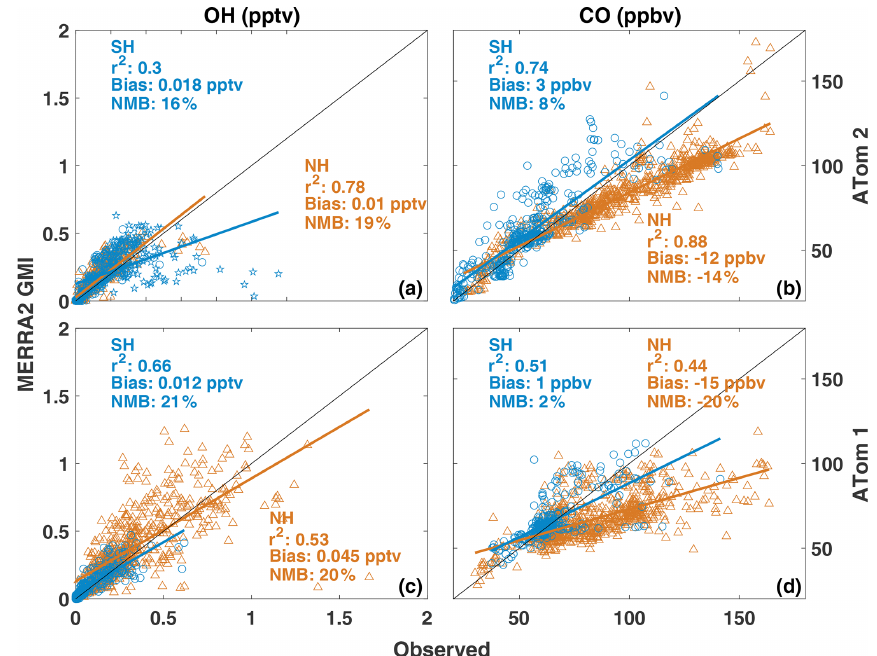
Figure 1. Regression of observed OH (a, c) and CO (b, d) from ATom 2 (boreal winter 2017; a , b ) and ATom 1 (boreal summer 2016; c , d ) against hourly output from MERRA-2 GMI interpolated to the ATom flight track. Data from the Southern (blue circles) and Northern (orange triangles) hemispheres are shown, along with the r 2 , bias, and normalized mean bias (NMB) for each hemisphere. Observations and model output have been filtered for biomass burning influence. Observations of continental outflow from New Zealand and South America from ATom 2 are indicated by blue